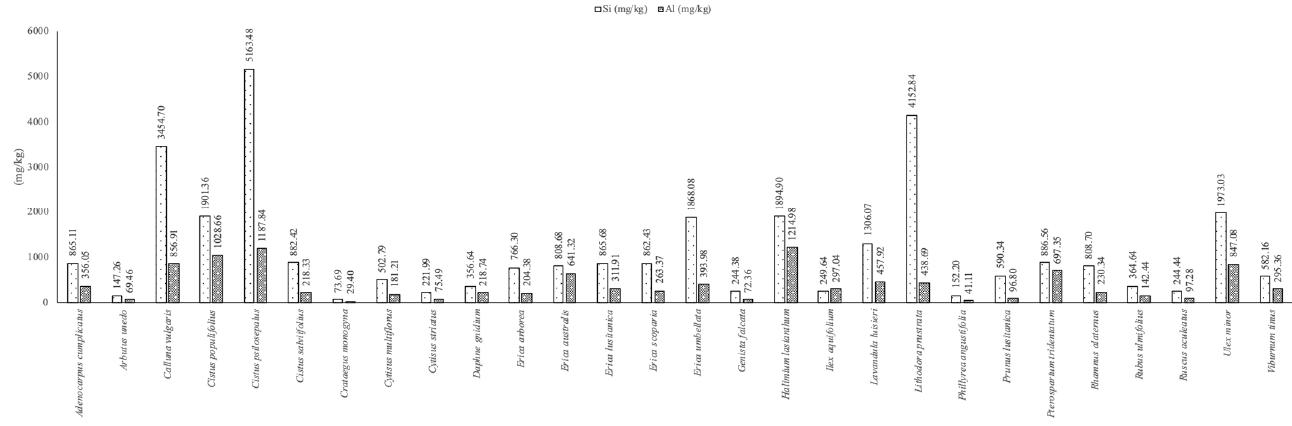
Figure 14. Si and Al contents (mg/kg).